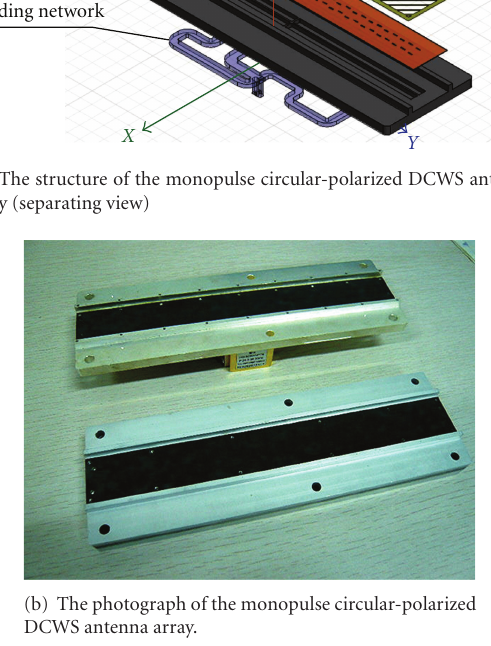
Figure 8: Ka-band monopulse circular-polarized dielectric com- plex waveguide slot (DCWS) antenna array.